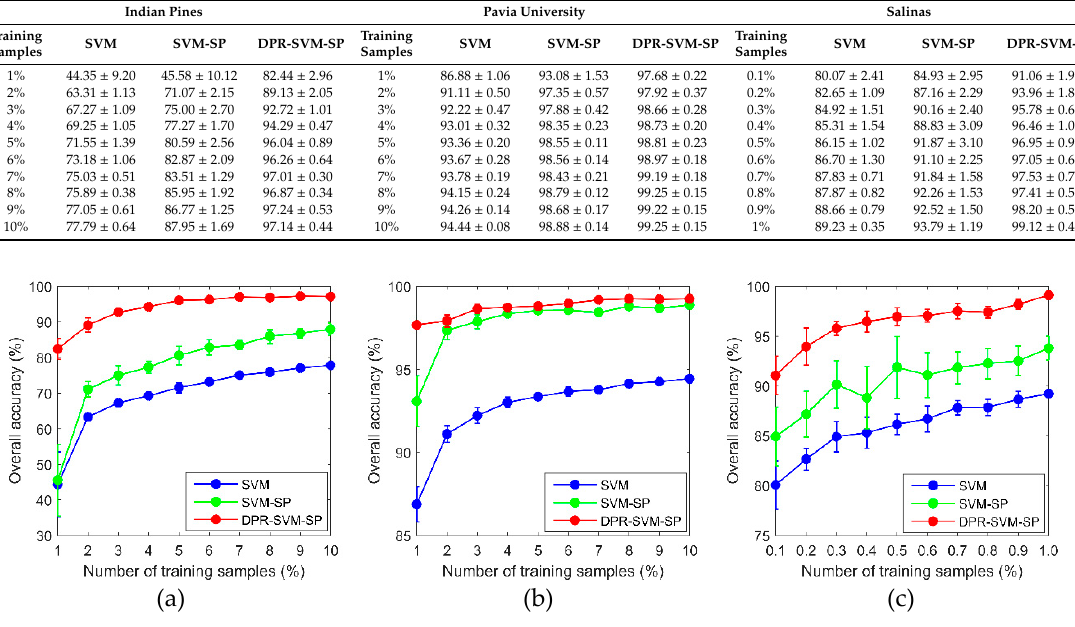
Figure 12. The visualization of results in Table 7. (a) Indian Pines. (b) Pavia University. (c) Salinas.